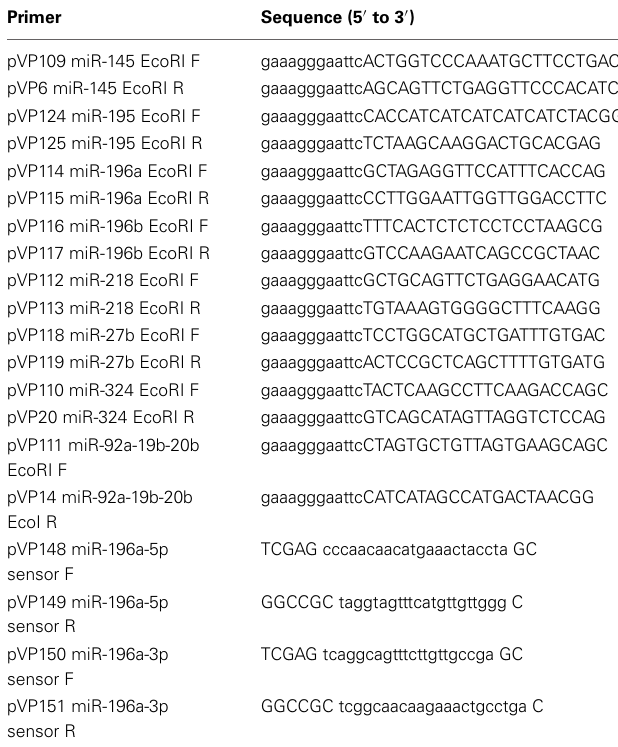
Table 2 | Oligos for miRNA overexpression and miRNA sensors. Primer Sequence (5 (cid:4) to 3 (cid:4)